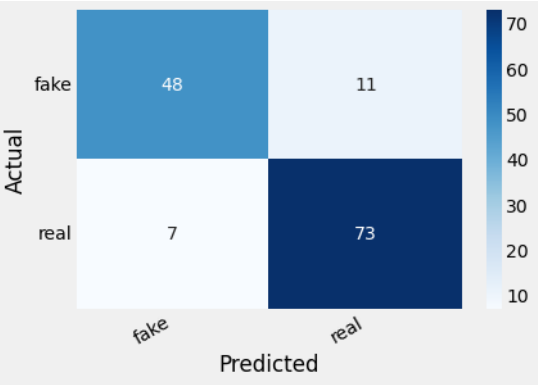
Figure 5. Confusion matrix of BERT base -BiGRU-CNN-ATT in